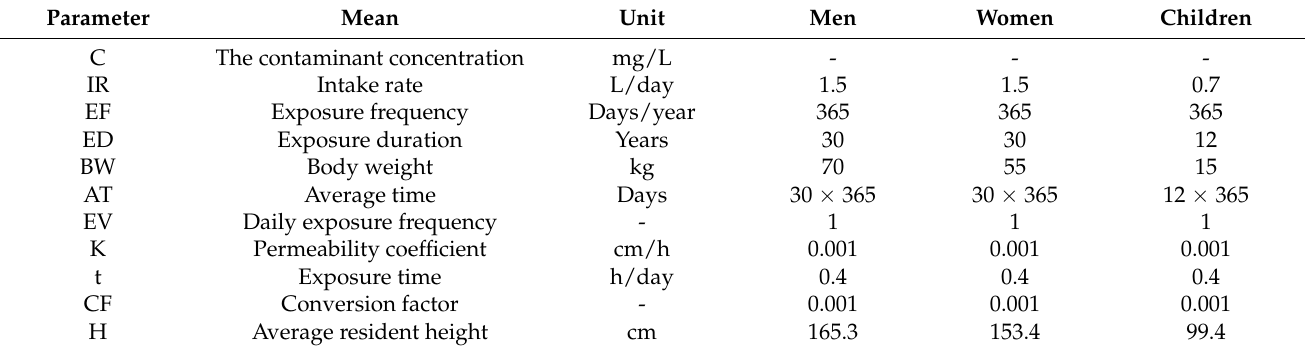
Table 2. Description and value of calculated parameters for noncarcinogenic risk by oral and dermal exposure. Parameter